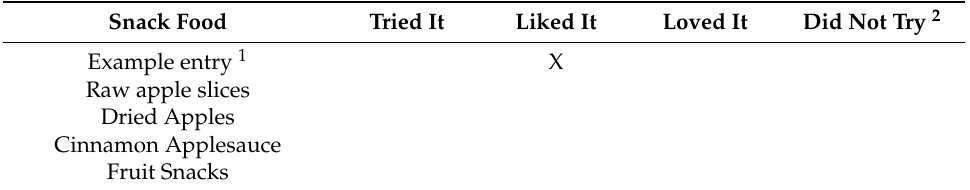
Table 5. The Tried It, Liked It, Loved It Survey.